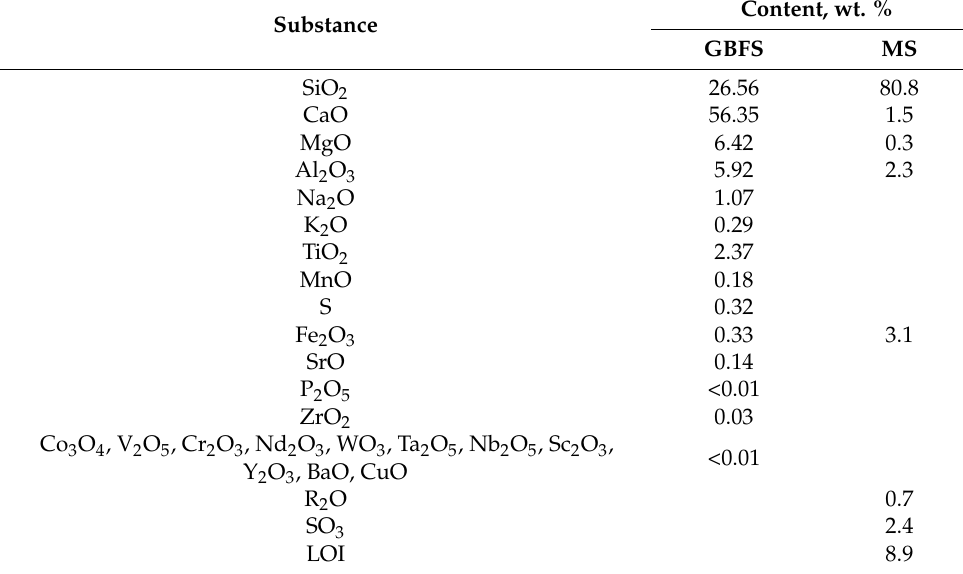
Table 4. Chemical composition of GBFS [52] and